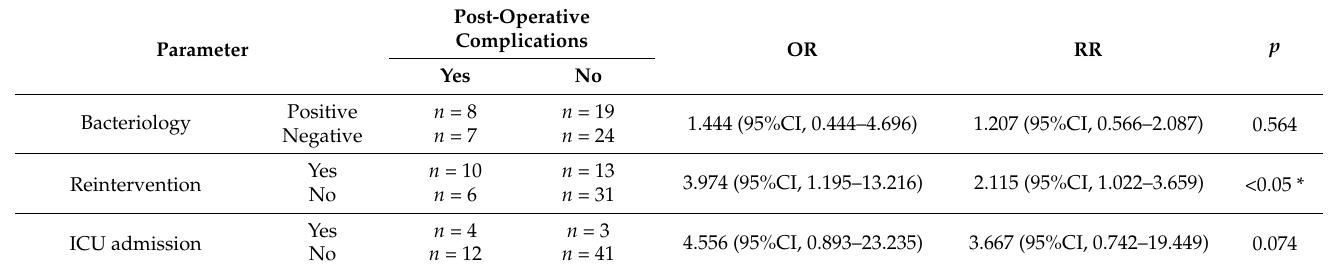
Table 6. Comparison of bacteriology assay results, reintervention, and ICU admission between patients that developed post-operative complications and those that did